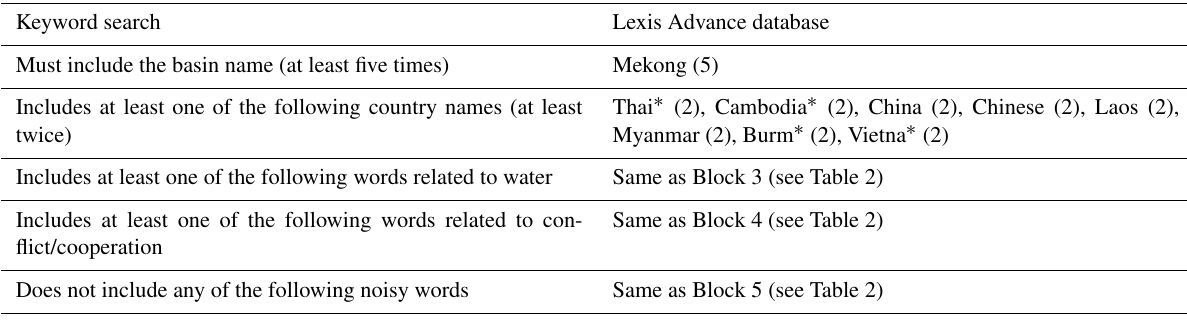
Table 3. Search keywords in the study (using Lancang–Mekong as an